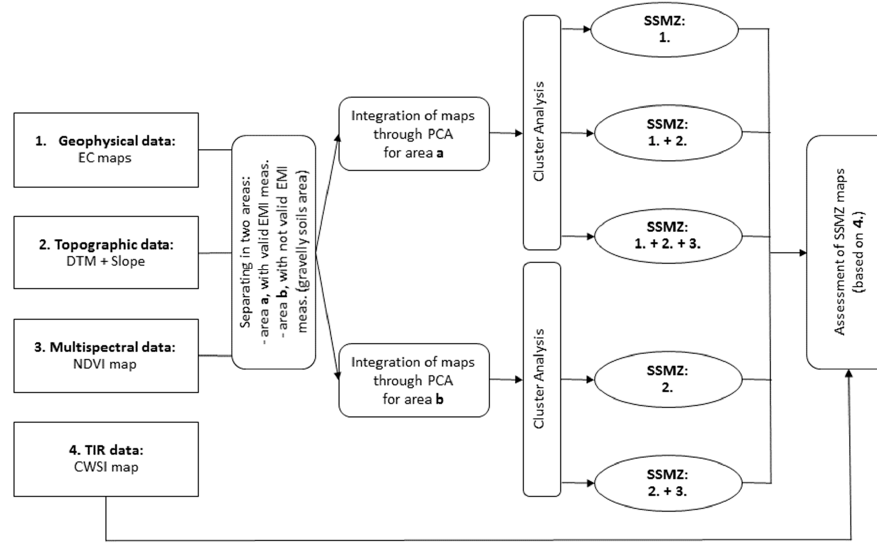
Figure 4. Scheme of the methodological approach adopted in this study.